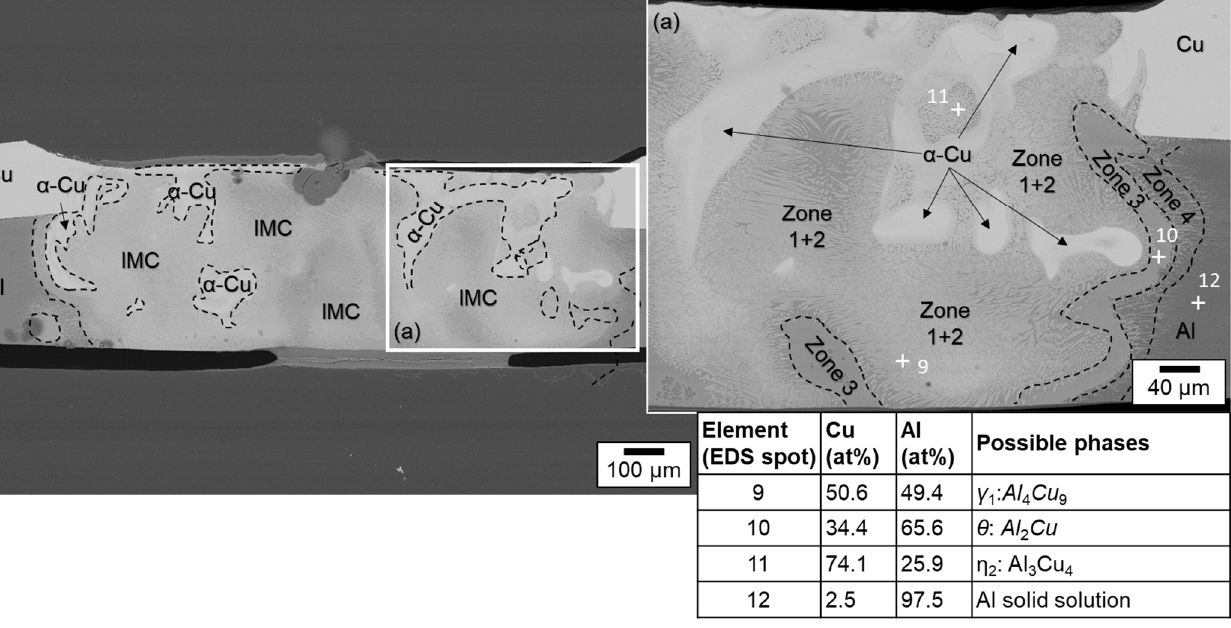
Figure 18. SEM image and EDS scanning spots in the weld seam of the sample produced with parameter set #6; white insert (a) indicates the area of the displayed detail image (a); dashed line indicates intermetallic phases ( top ); EDS phase composition at selected scanning spots ( right bottom ).